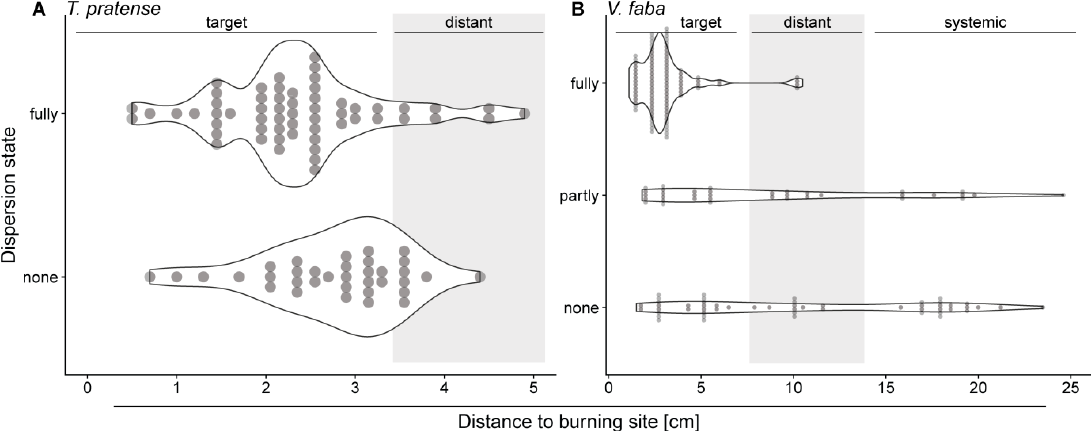
Figure 4. Effect of increasing distance and internode intermissions on forisome dispersion (fully, partly, none) after a heat stimulus to T. pratense ( A ) and V. faba ( B ). The width of the violin plots is adjusted to the count of forisomes observed in a given state at a given distance (each forisome indicated by a filled circle). For T. pratense 115, for V. faba 184 forisomes were monitored. Statistical values are shown in the text.